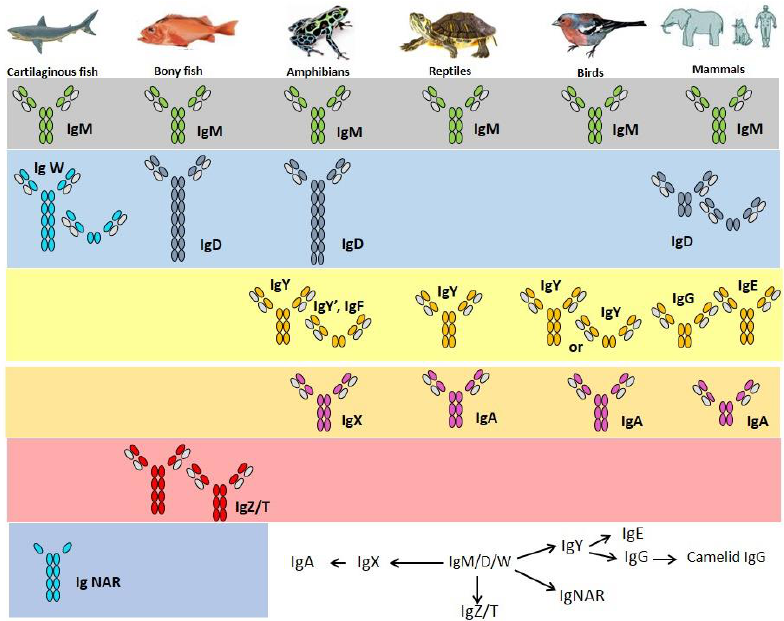
Figure 2. Immunoglobulin heavy chain isotypes of fish and their proposed [110] relationships with the isotypes of other vertebrate groups, which is still quite controversial.